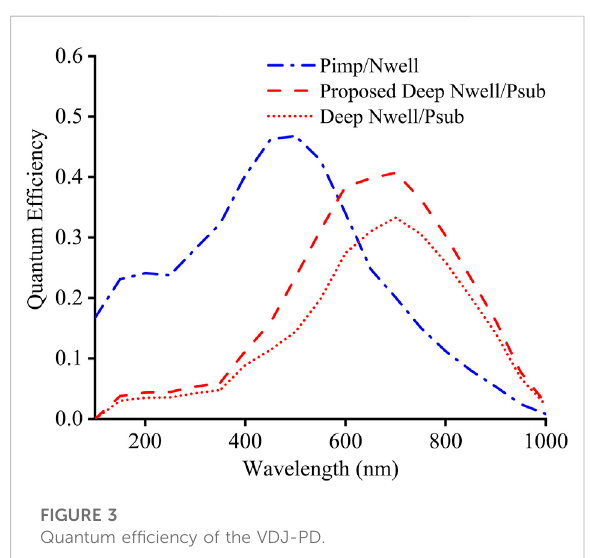
FIGURE 3 Quantum ef fi ciency of the